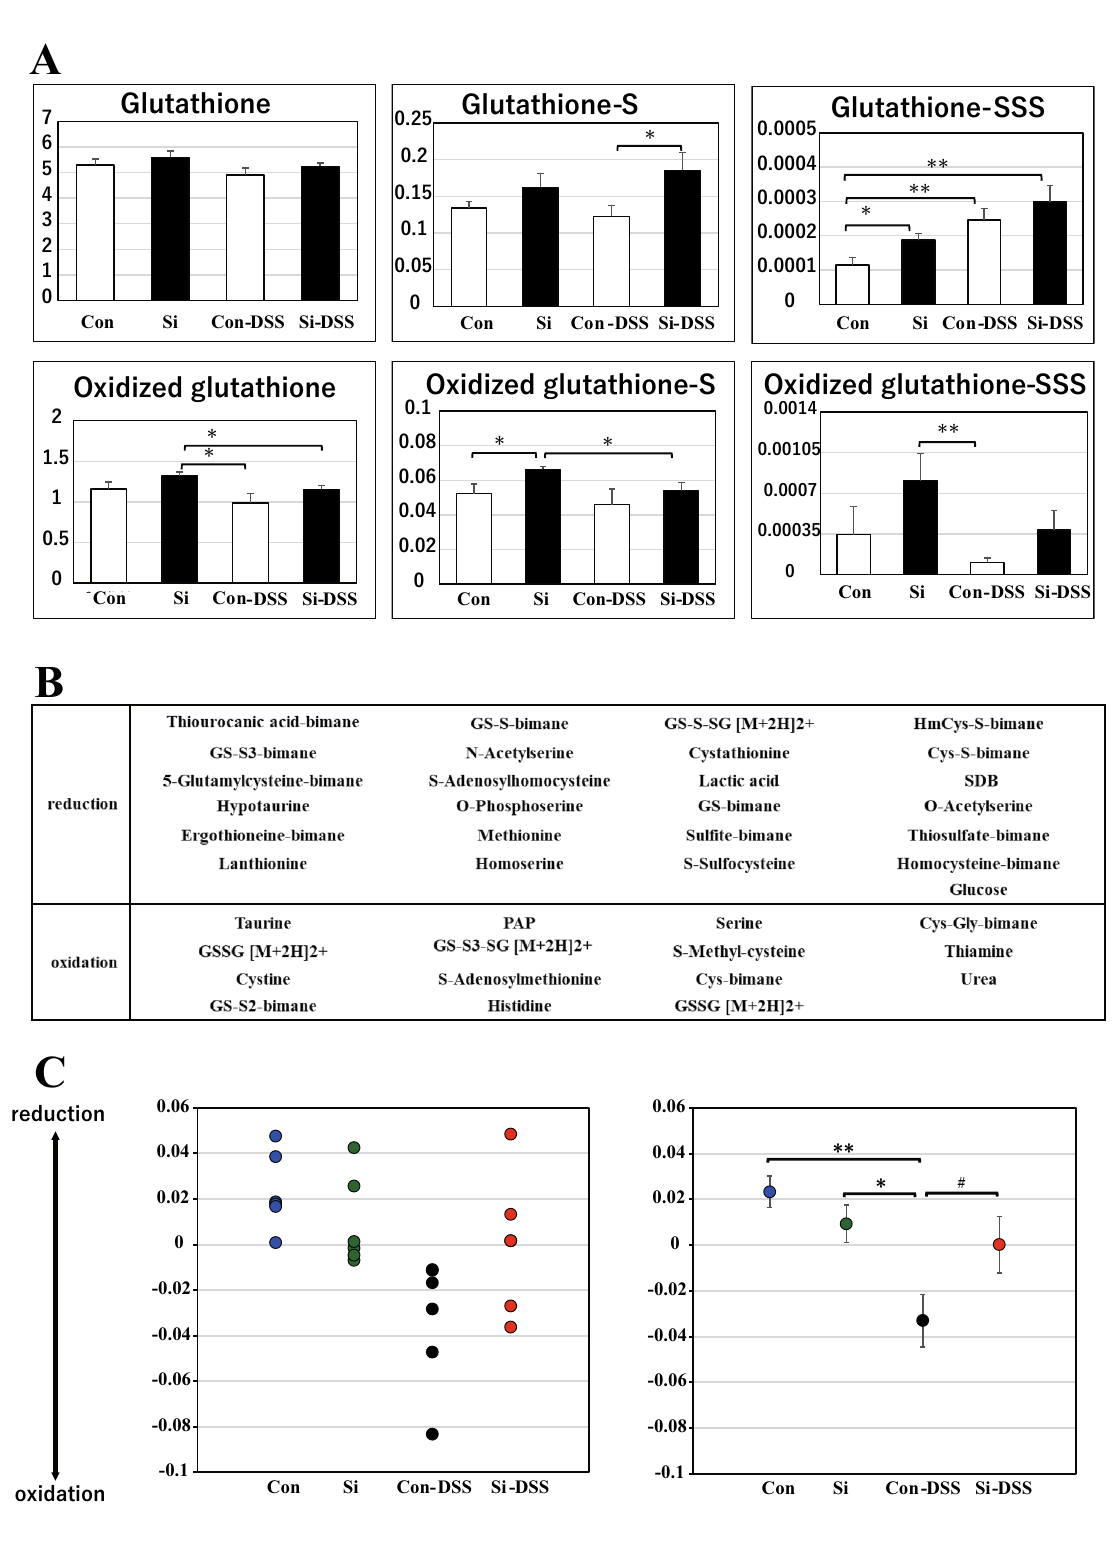
Figure 7. The caption to be typeset alongside it: Si-based agent suppressed the intestinal oxidation associated UC via antioxidant sulfur compounds. Sulfur index analysis of the mouse large intestine. The average bar graphs for the expression of glutathione, oxidized glutathione, and each persulfide ( A ). White: control or con-DSS group; black: Si or Si-DSS group. ( B ) Contributory compounds in sulfur-index analysis. ( C ) The dot graph of individual values and the average for sulfur index analysis. Data are expressed as mean ± SEM of six mice per group. ♯ p < 0.08, * p < 0.05, ** p < 0.01, determined by Student’s paired t